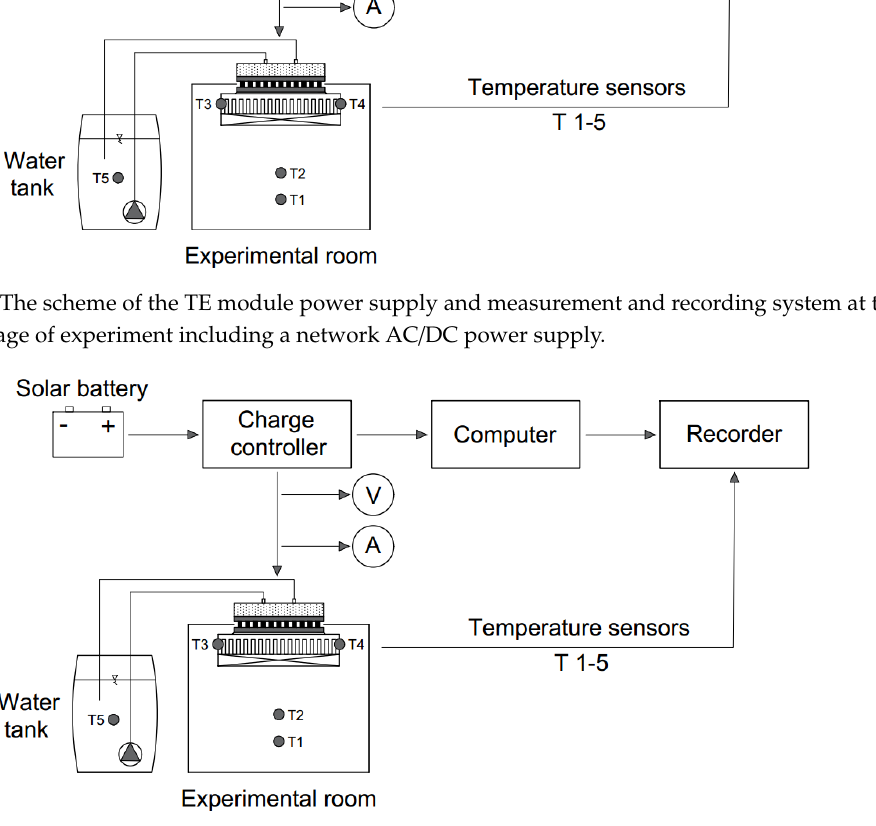
Figure 3. The scheme of the TE module power supply and measurement and recording system at the third stage of experiment where the TE module was powered from a solar battery.